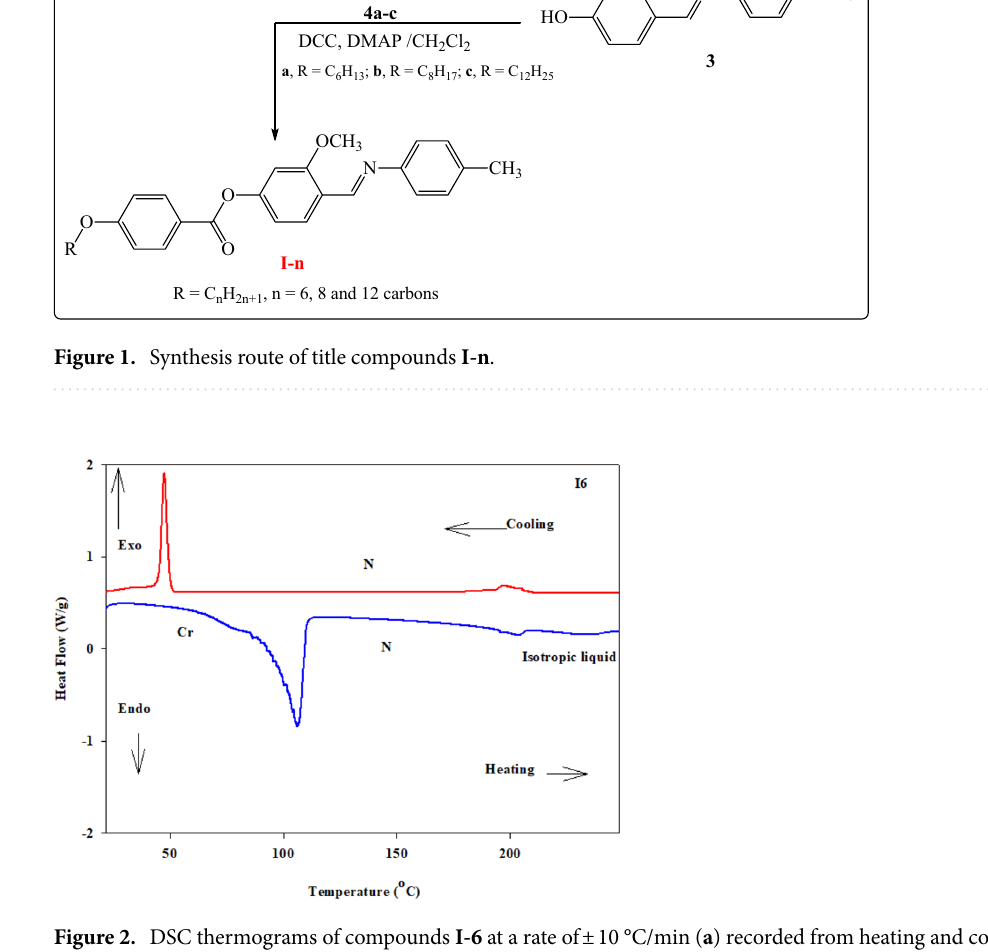
Figure 2. DSC thermograms of compounds I-6 at a rate of ± 10 °C/min ( a ) recorded from heating and cooling scans.